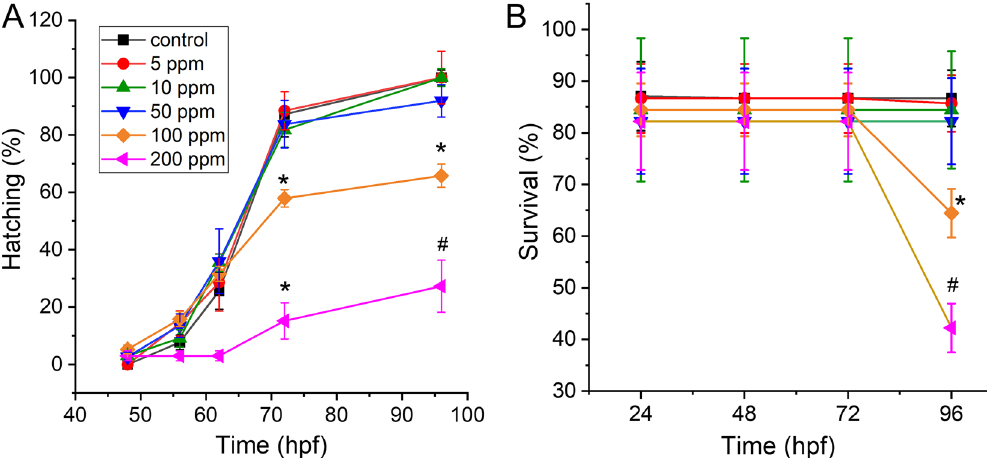
Figure 2. Effect of PET NPs on hatching ( A ) and survival rate ( B ) of zebrafish embryos. Embryos at 6 hpf were exposed to different concentrations (i.e., 0, 5, 10, 50, 100 and 200 ppm) of PET NPs for 24, 48, 72 and 96 h. Values shown are the mean ± standard deviation (n = 30 embryos per group). For statistical analysis, one-way ANOVA was performed using OriginPro v.8 (OriginLab, Northampton, MA, USA). The statistically significant differences in hatching and survival rate between PET NPs treated and control group obtained by ANOVA analysis are indicated by * p < 0.05 and # p < 0.01 as compared to untreated